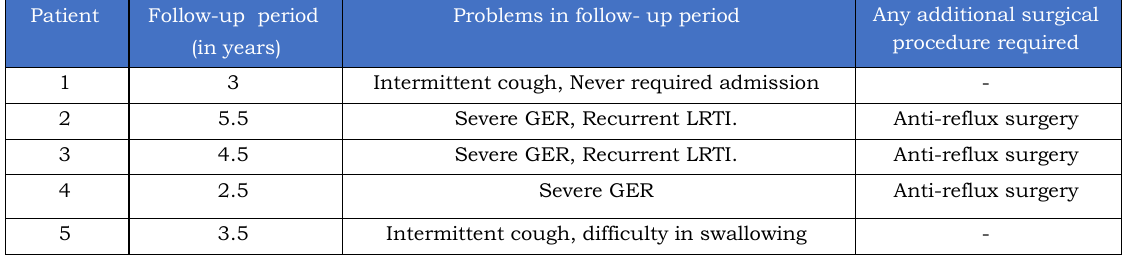
Table No.5: Association of Nature of Pharyngeal or Endotracheal Aspirate and